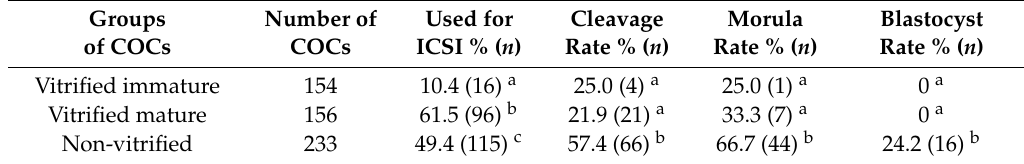
Table2. Developmentalcompetenceofimmatureandmaturecatoocytesvitrifiedbythecryotopmethod.